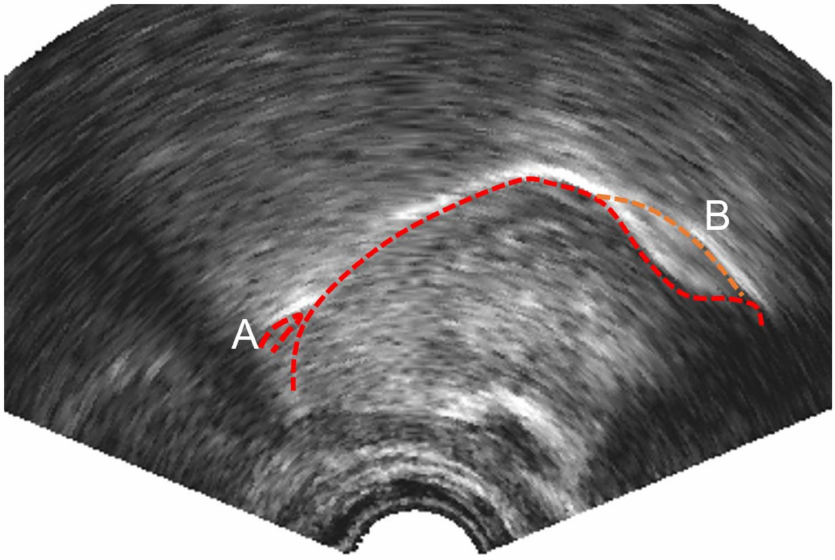
Figure 3. Ultrasound image showing ( A ) bright reflection from tip of epiglottis ( B ) double reflection parasagittal surface (upper) and midsagittal surface (lower) of the tongue